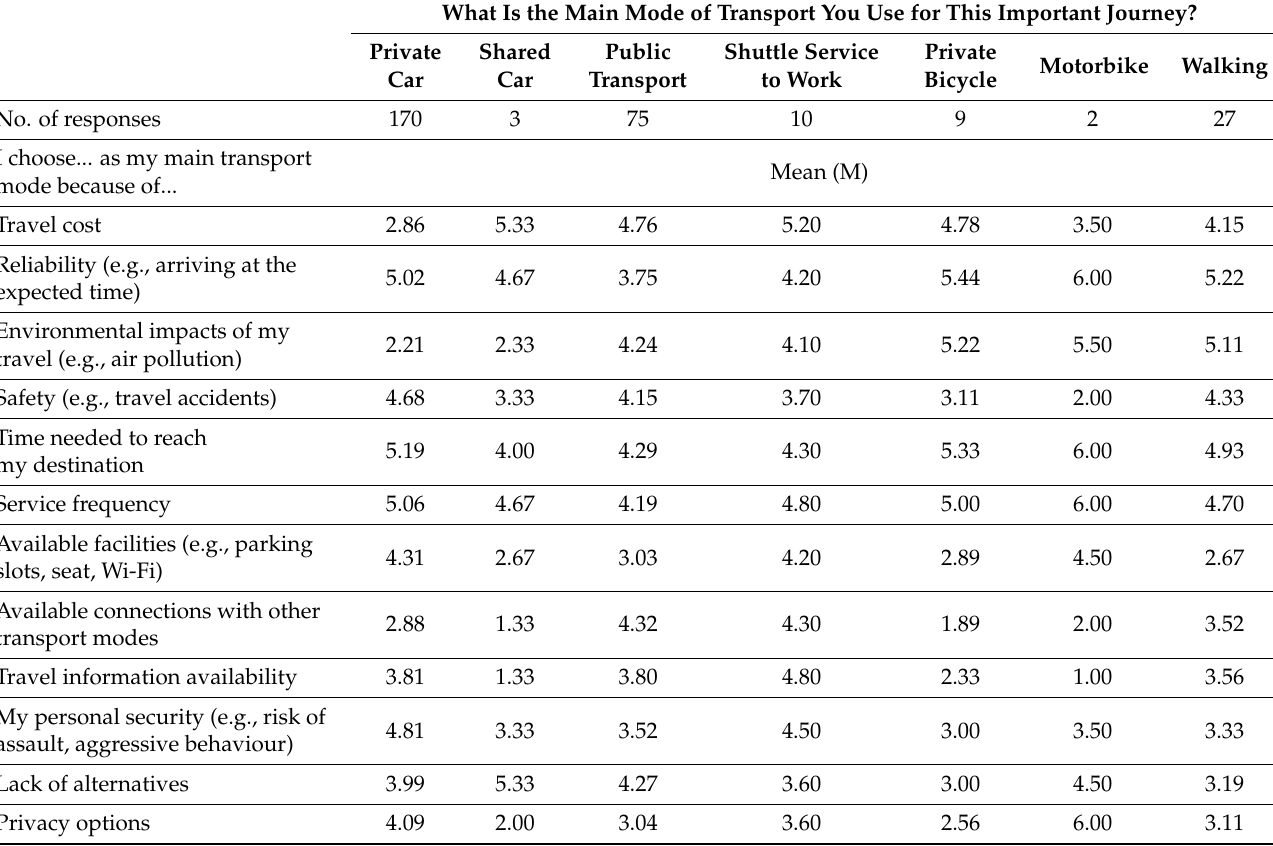
Table 4. Factors that determine the mode of transportation for the respondents’ most important